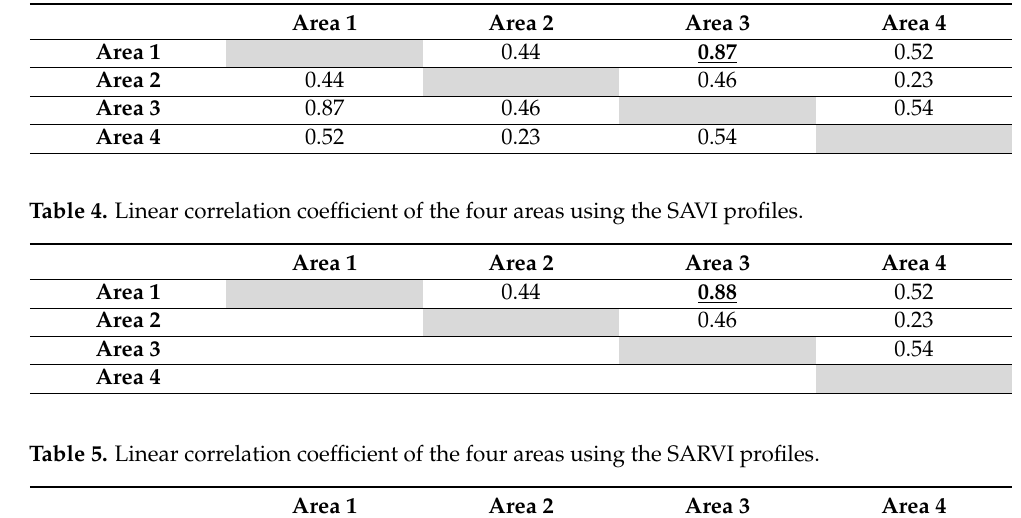
Table 3. Linear correlation coefficient of the four areas using the NDVI profiles.